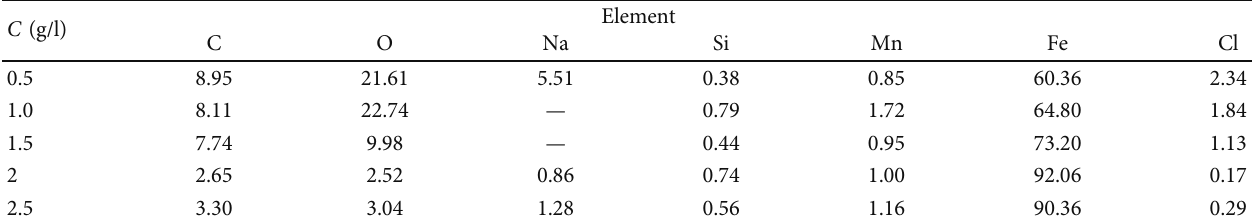
Table 5: Corrosion rate ( K Environment